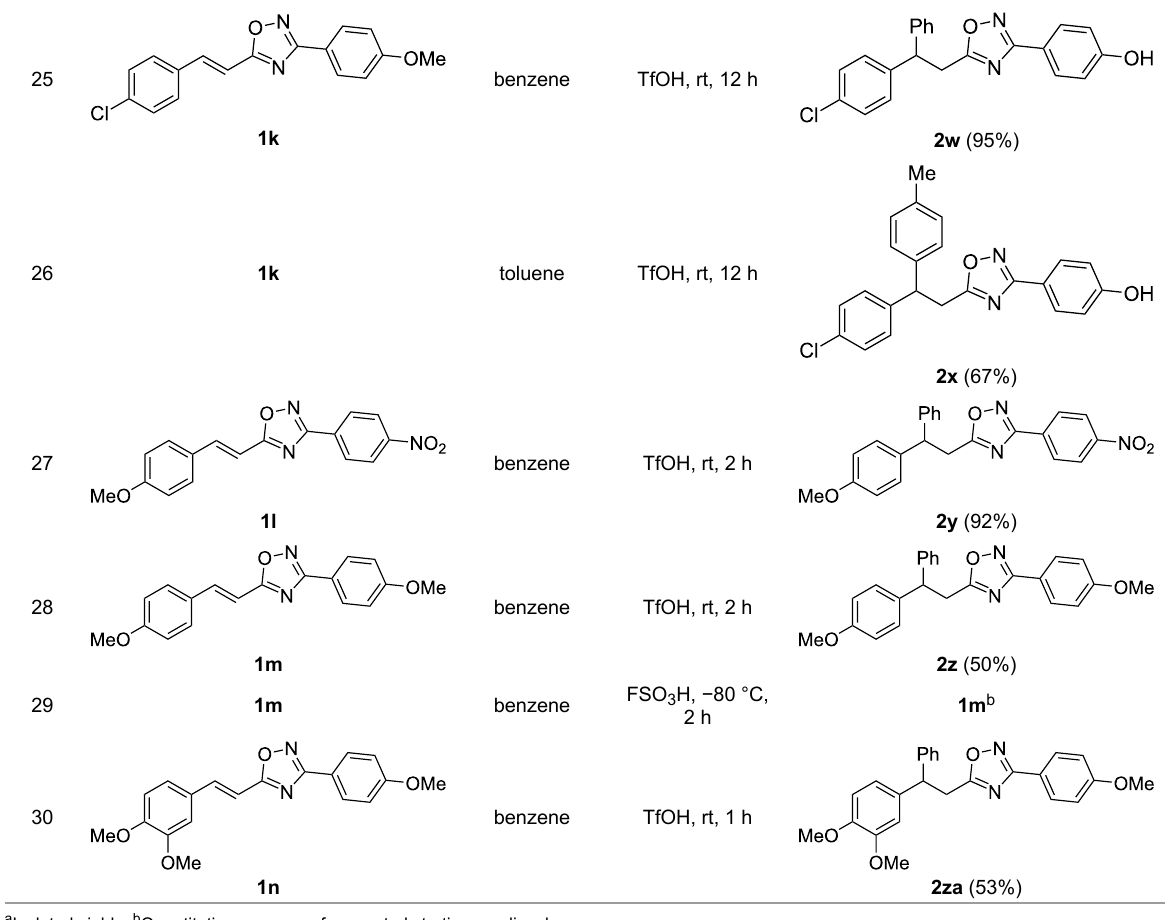
Table 2: Hydroarylation of oxadiazoles 1a–n with arenes under superelectrophilic activation leading to compounds 2a–za . (continued)